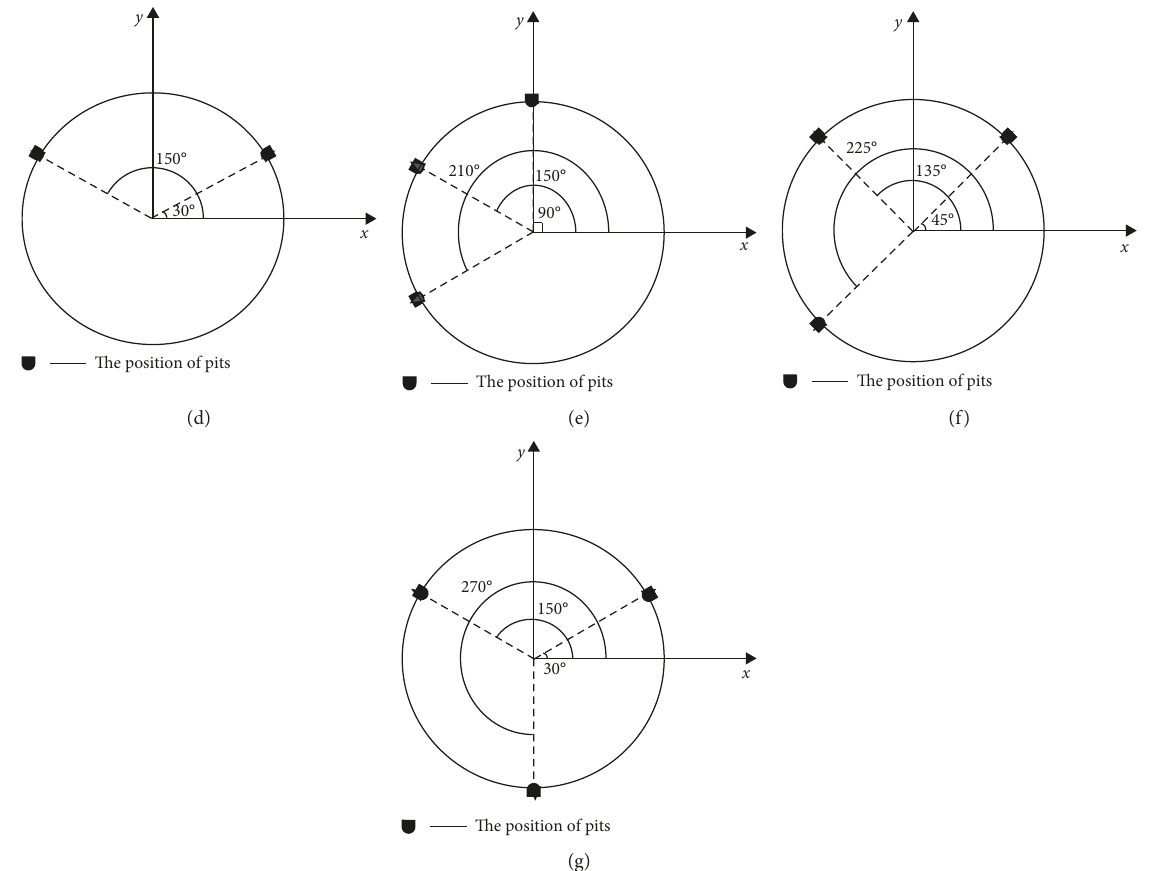
Figure 18: Schematic diagram of the cross section of steel wires with the different planar multifatigue sources: (a) Case A; (b) Case B; (c) Case C; (d) Case D; (e) Case E; (f) Case F; (g) Case G.